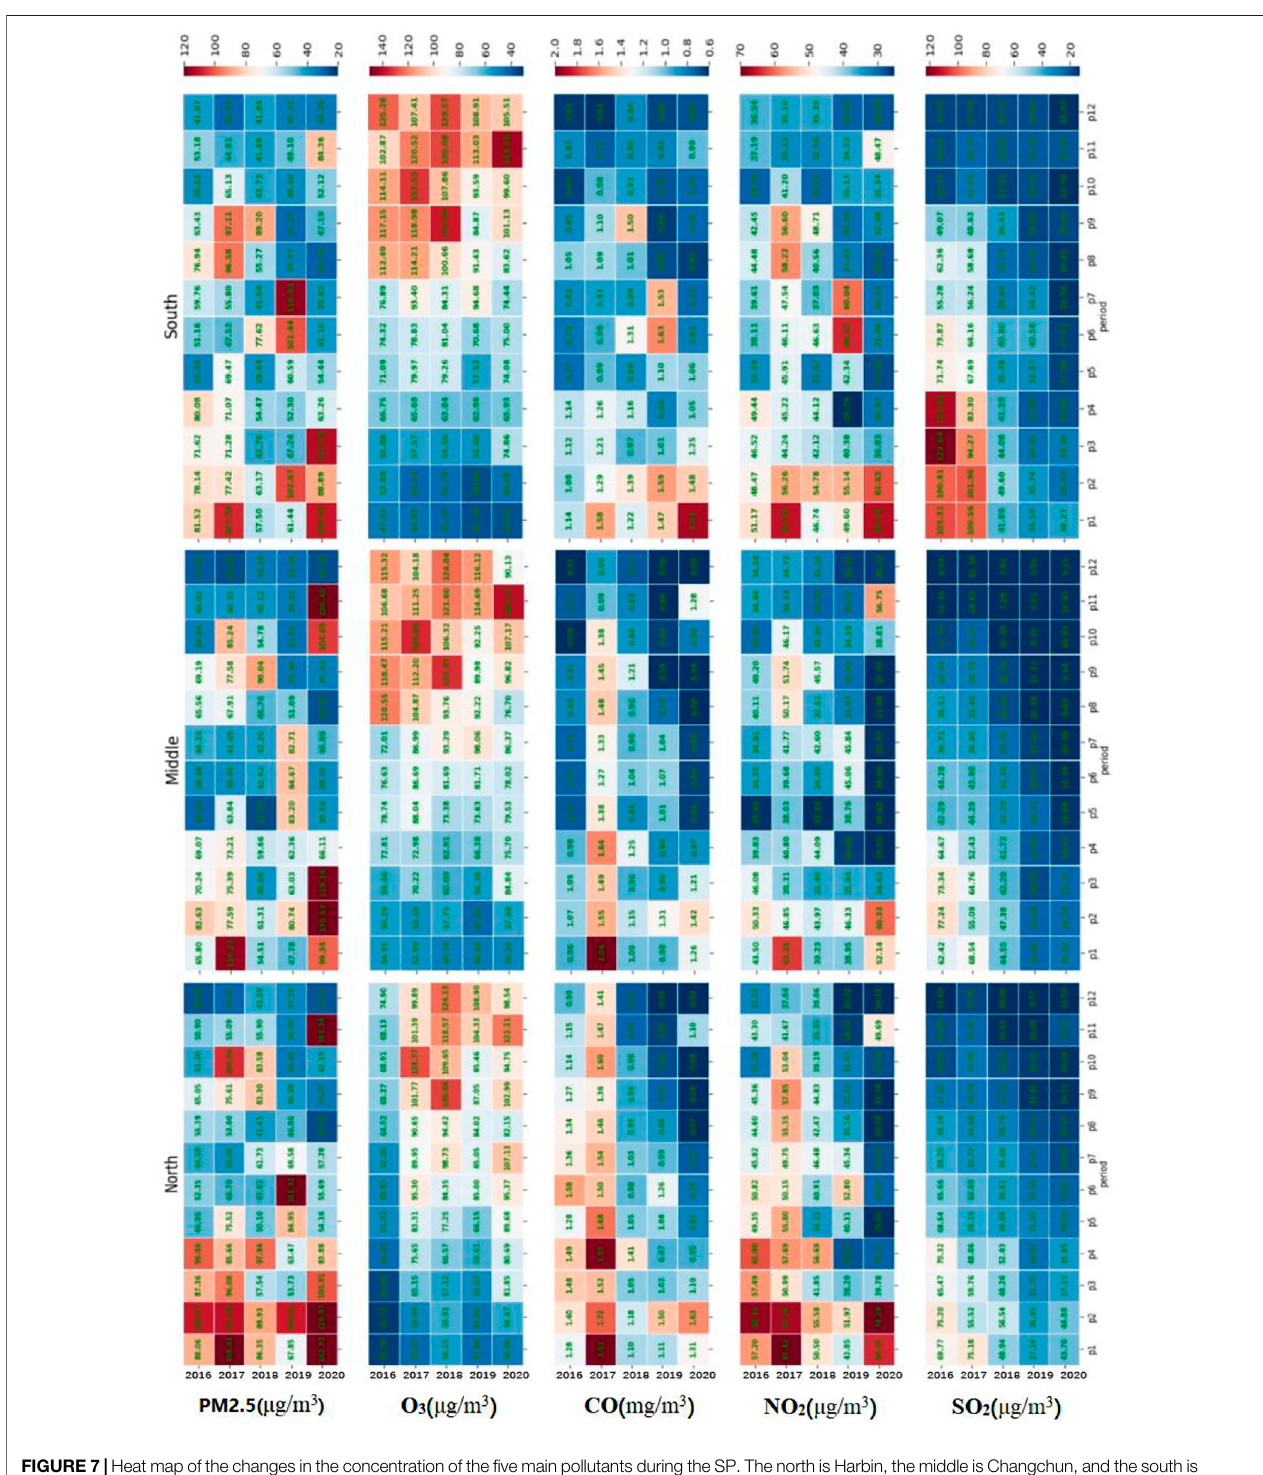
Frontiers in Environmental Science |